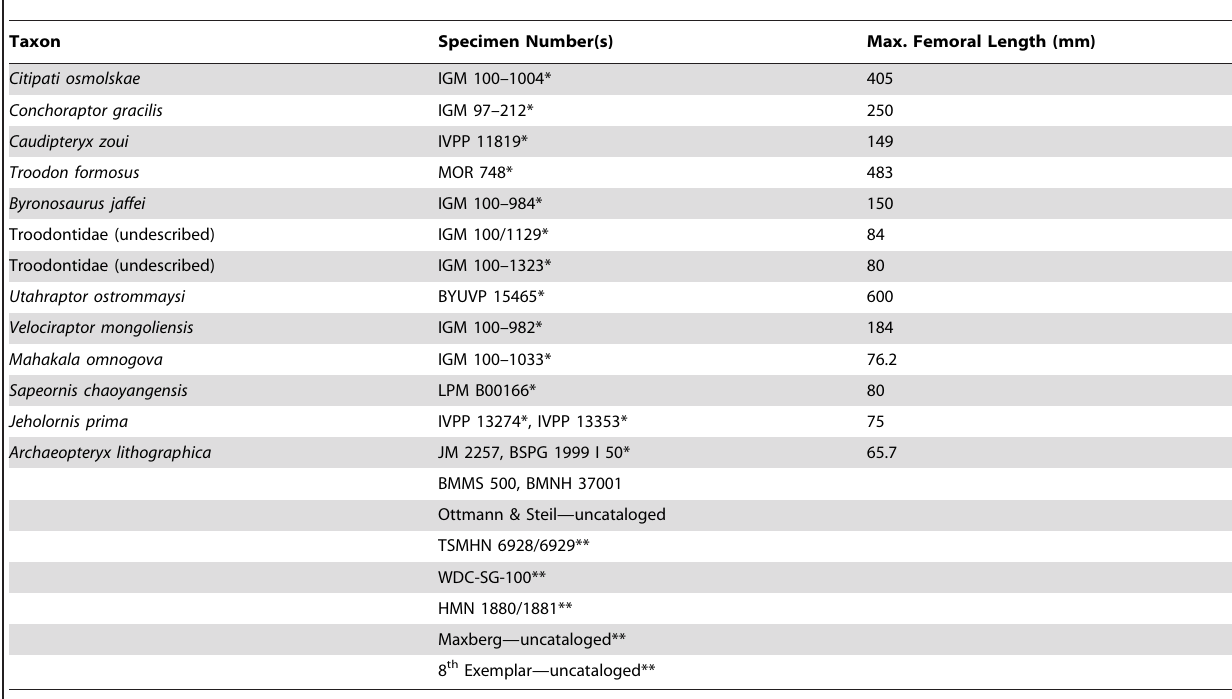
Figure 1. Long bone histology of a non-avialan dinosaur and a Mesozoic bird viewed with polarized microscopy. (A) The femoral microstructure of the small alvarezsaurrid, Shuvuuia deserti (IGM 100–99) is compared to the tibial histology (B) of the Early Cretaceous avialan, Confuciusornis sanctus (IVPP V11521). Both show well-vascularized bone owing to the presence of numerous primary vascular canals (large black structures), and woven fibered matrix characterized by oblong, randomly oriented osteocyte lacunae (numerous small black structures). Arrows point to growth lines in the form of a line of arrested growth (left) and an annulus (right). Scale bars =0.5 mm (A) and 0.1 mm (B). doi:10.1371/journal.pone.0007390.g001 Table 1. Specimen identifications and